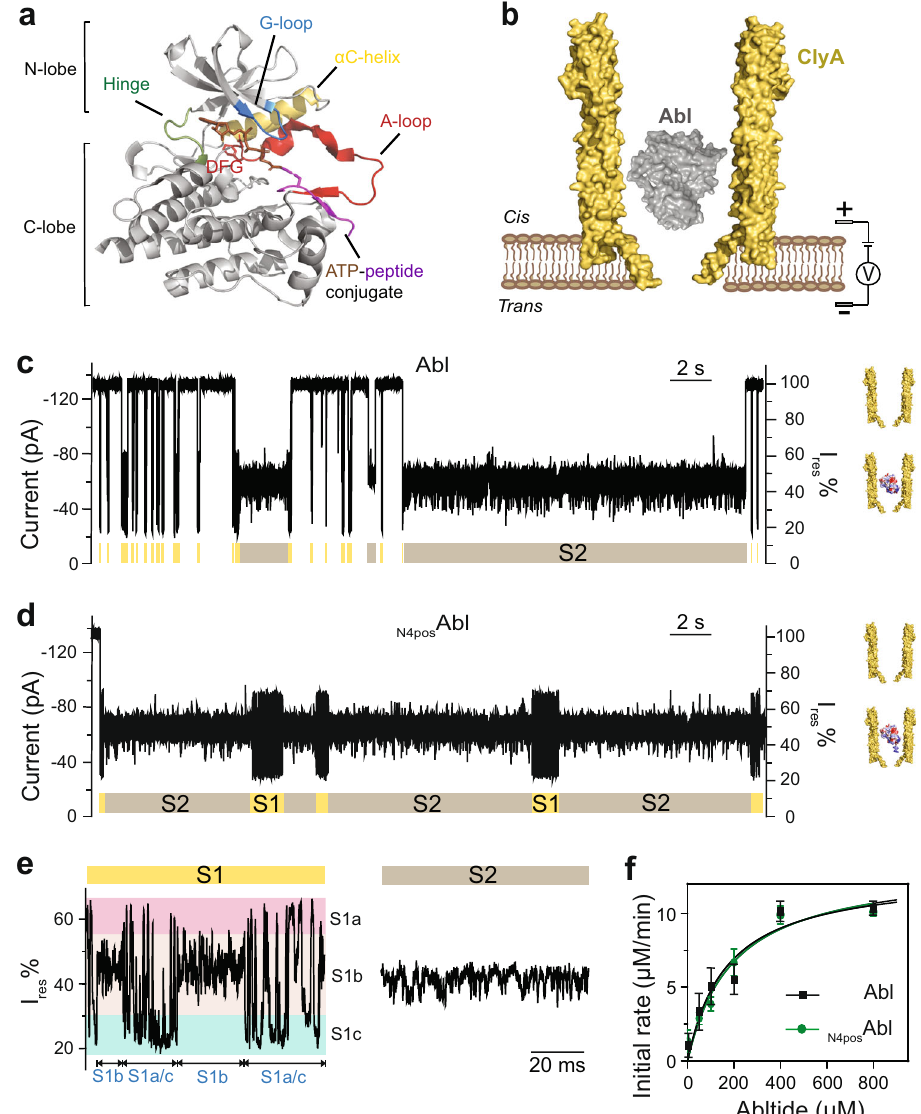
Fig. 1 Trapping of apo Abl kinases with ClyA nanopore tweezers. a Crystal structure of the catalytic domain of human Abl kinase (Abl, gray) bound with ATP-peptide conjugate (PDB: 2G1T). ATP in brown and peptide in purple. Structural elements are indicated with different colors, hinge in green, G-loop in blue, α C-helix in yellow, and A-loop in red. Side chain of DFG-motif is shown as stick. b Schematic representation of a single Abl kinase (gray) con fi ned in a ClyA nanopore (yellow) embedded in a planar lipid bilayer (brown) with negative applied potential at trans . c , d Representative current traces and schematics of Abl ( c ) and N4pos Abl ( d ) trapped in a ClyA nanopore. N4pos Abl indicates Abl attached with a positively charged peptide tail at its N-terminus. Peptide sequence for N4pos tag: KRKKSGG. Signal pattern S1 (yellow), S2 (brown) are observed when Abl is trapped within nanopore. e Zoomed in trace of S1 and S2 states from N4pos Abl trapping signal. Three sub-states were observed within S1, namely, S1a (highlighted with a pink band), S1b (highlighted with a beige band), and S1c (highlighted with a cyan band). The state transition pathways were: S1 ↔ S2, S1a/c ↔ S1b, and S1a ↔ S1c. S1a/c indicates an S1a/c joint state. f Michaelis-Menten kinetics analysis of Abl (black) and N4pos Abl (green). Data were represented as mean ± SD, n = 3 independent replicates. Source data are provided as a Source Data fi le. The current traces were collected at − 80 mV in 150 mM NaCl, 100 mM Tris-HCl, pH 7.5, with ∼ 100 nM Abl or cis chamber, at 22 N4pos Abl added to